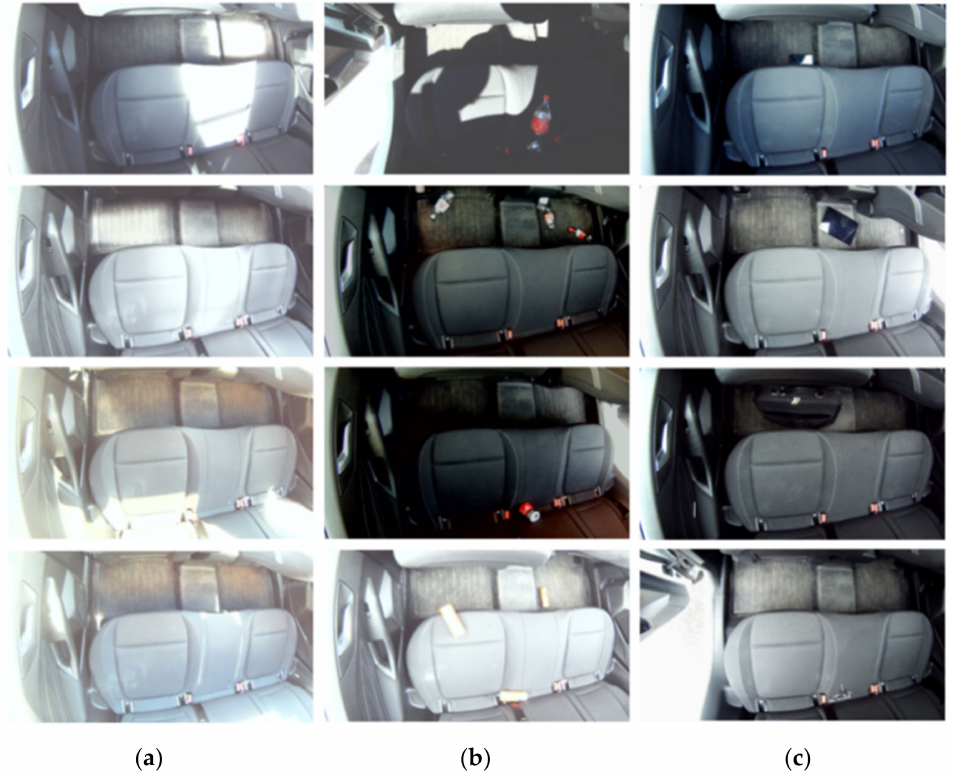
Figure 6. A series of captured images belonging to the three distinct classes ( a ) empty, ( b ) trash and ( c ) valuable,